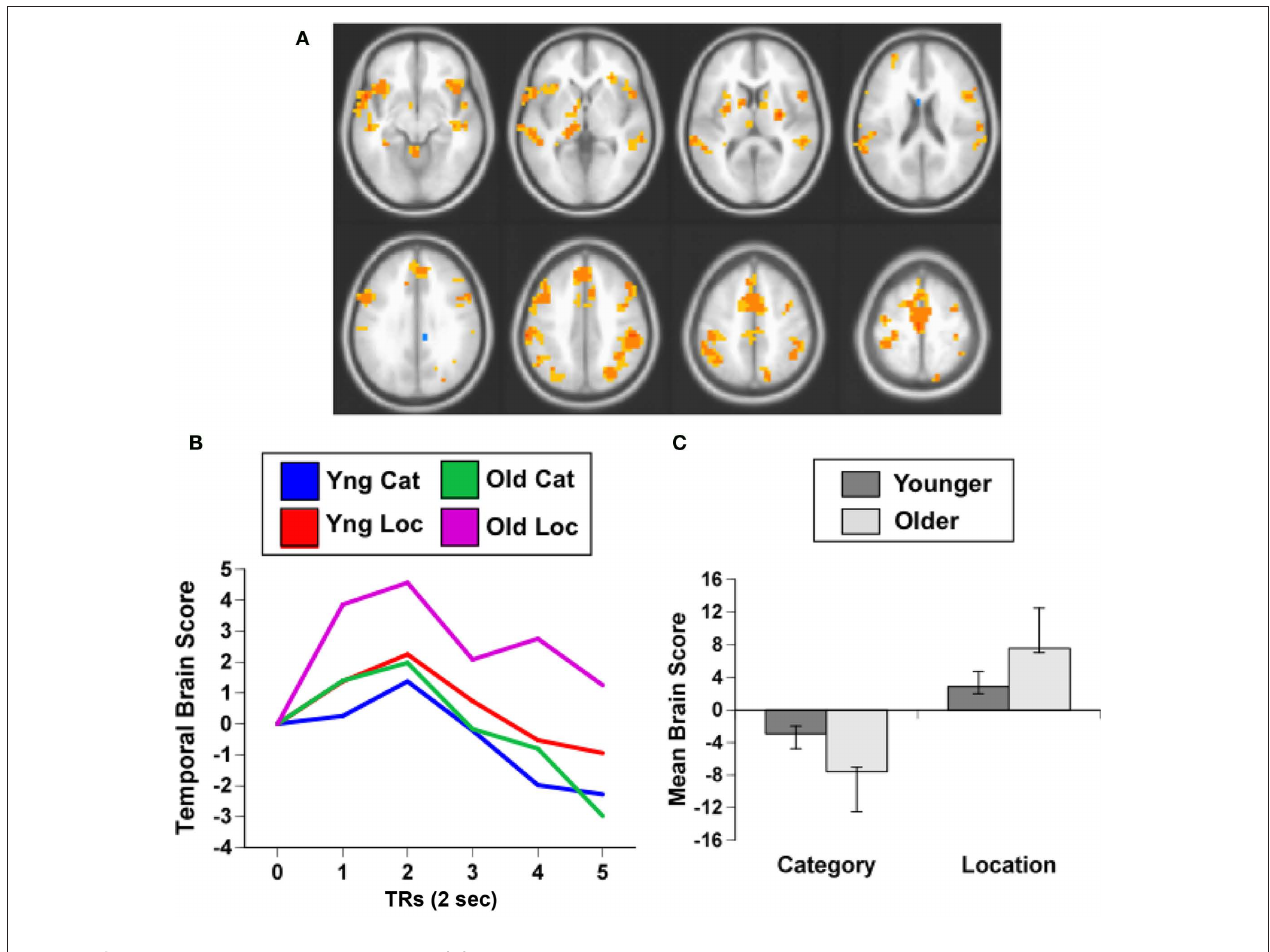
centered (zero in the graph represents overall mean activity). Error bars are the 95% confidence intervals (CIs) calculated from the bootstrap. Non-overlapping CIs indicate a difference between category and location conditions in both groups as well as an age difference within each